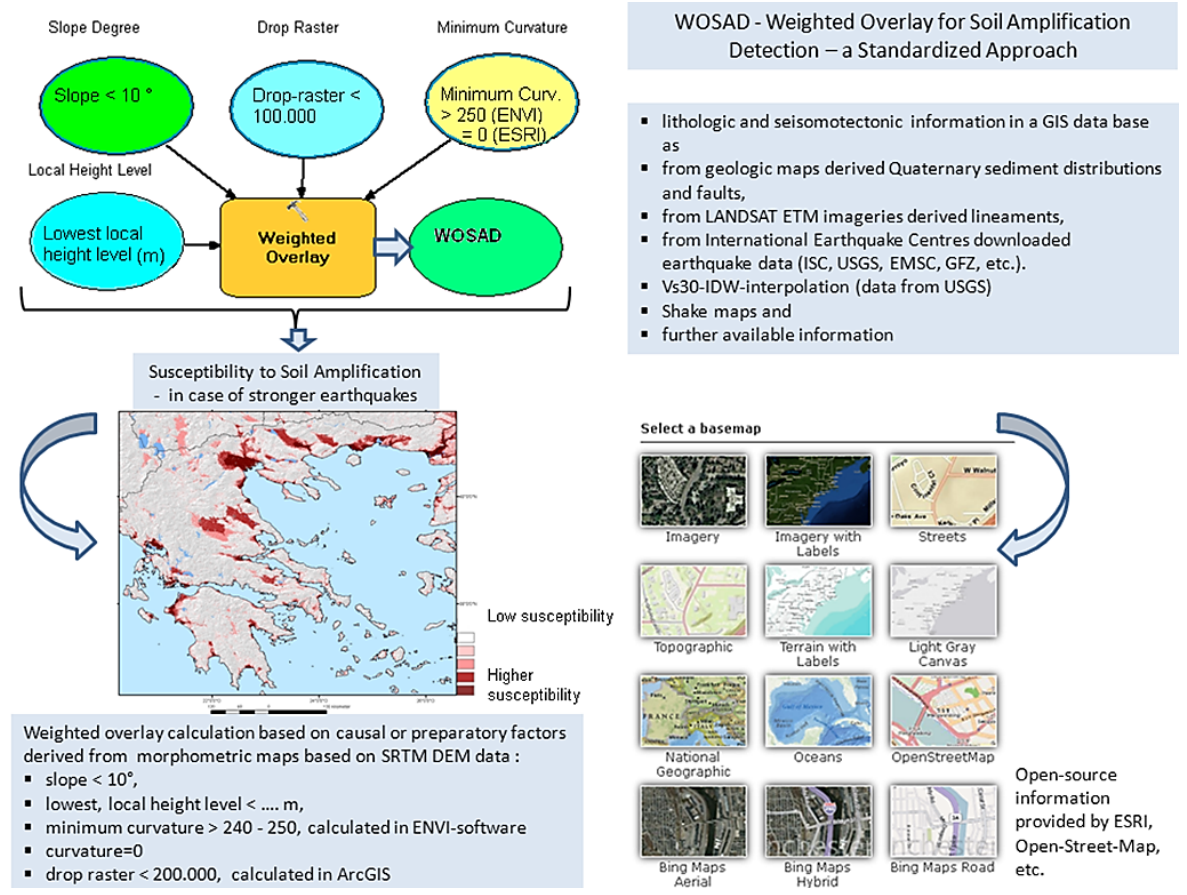
Figure 3. Workflow for the weighted overlay approach aggregating factors with influence on local site